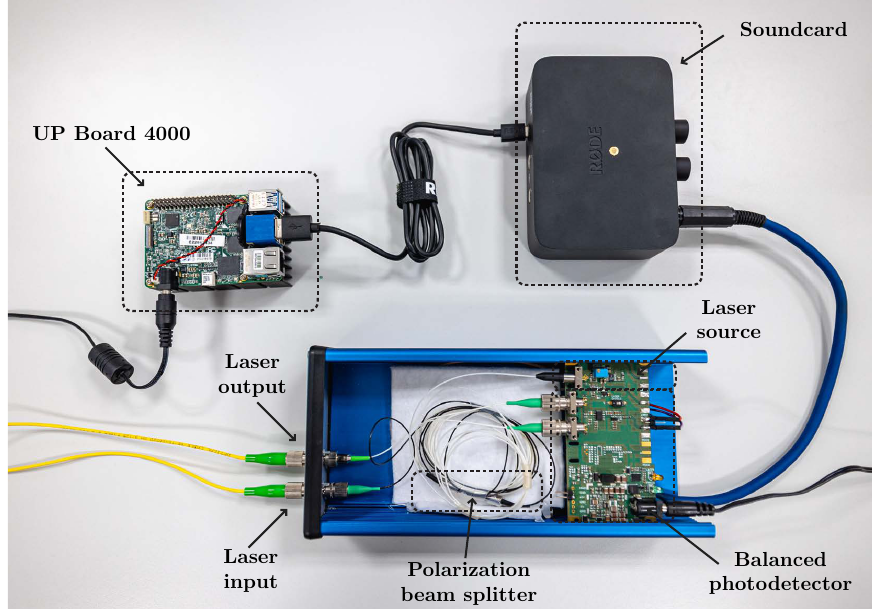
Figure 4. Final version of the sensor system with real